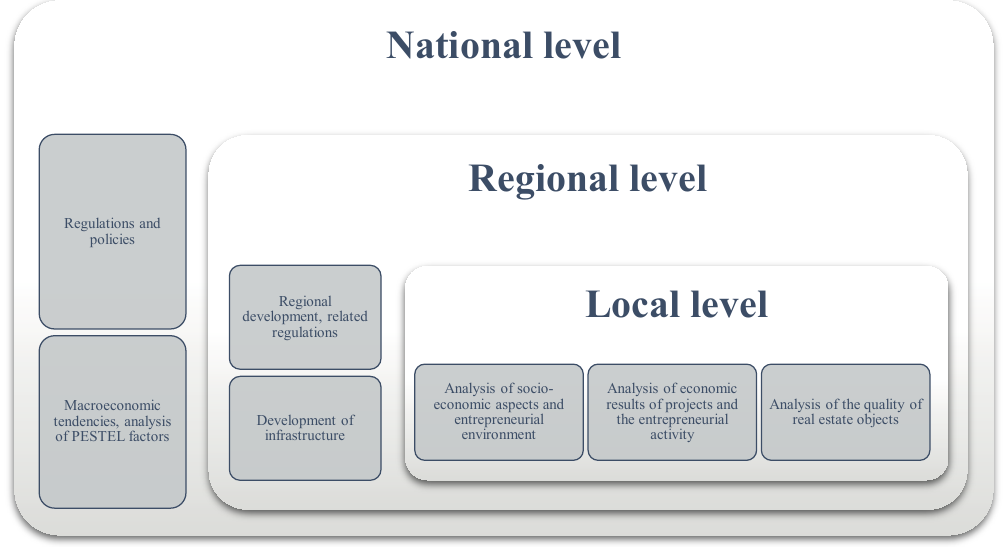
Fig. 2. The system of the analysis of the sustainable construction and the related environment (Source: developed by the authors based on (Kauskale, 2018)). Note: PESTEL – political, economic, social, technological, environmental,